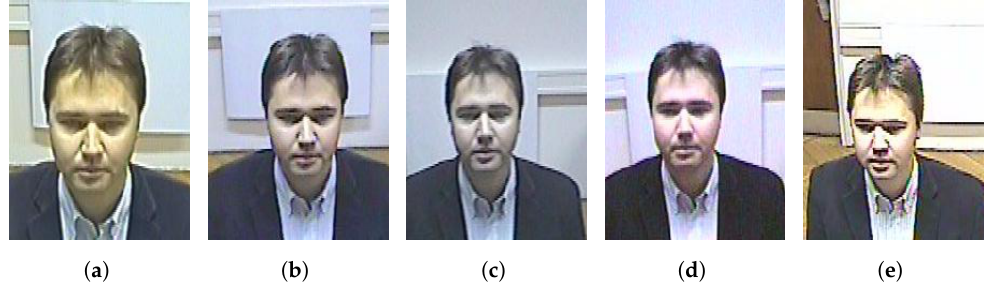
Figure 6. The color pictures from the security cameras acquired at 1 m distance from subject 001 of the SCFace database. The first four images ( a – d ) depict a frontal face. The fifth camera ( e ) acquires the face slightly on the right of the depicted